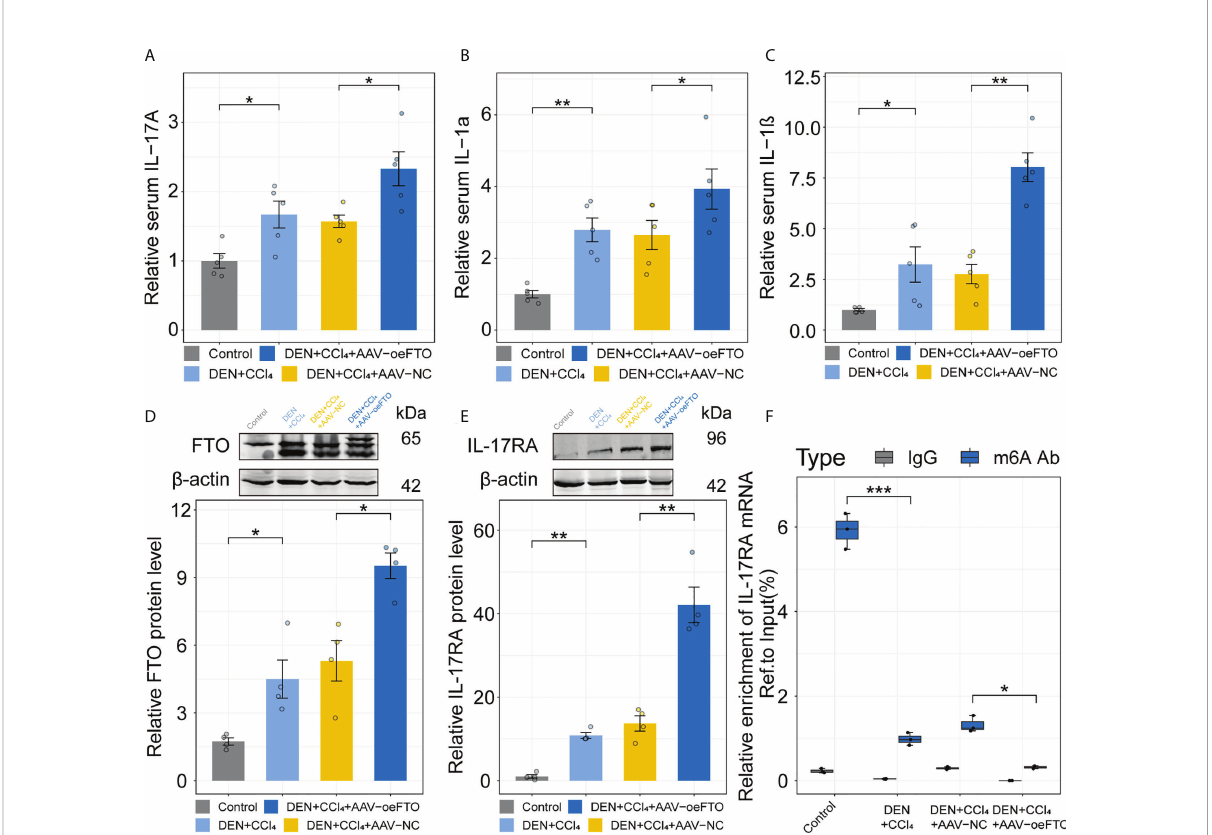
FIGURE 7 FTO facilitates liver in fl ammation via induction of IL-17RA in murine chronic liver injury model. (A-C) . Relative serum IL-17A, IL-1 a , and IL-1 b in all groups with different treatment. (D, E) . Relative FTO, and IL-17RA protein level in the control, DEN + CCl 4 , DEN + CCl 4 + AAV-NC, and DEN + CCl 4 + AAV-oeFTO groups. (F) . Relative m6A enrichment of IL-17RA mRNA in liver tissues of different groups by m6A-RIP-qPCR. All experiments were repeated at least three times and expressed as the means ± SEM. n = 5; * p < 0.05; ** p < 0.01; *** p <